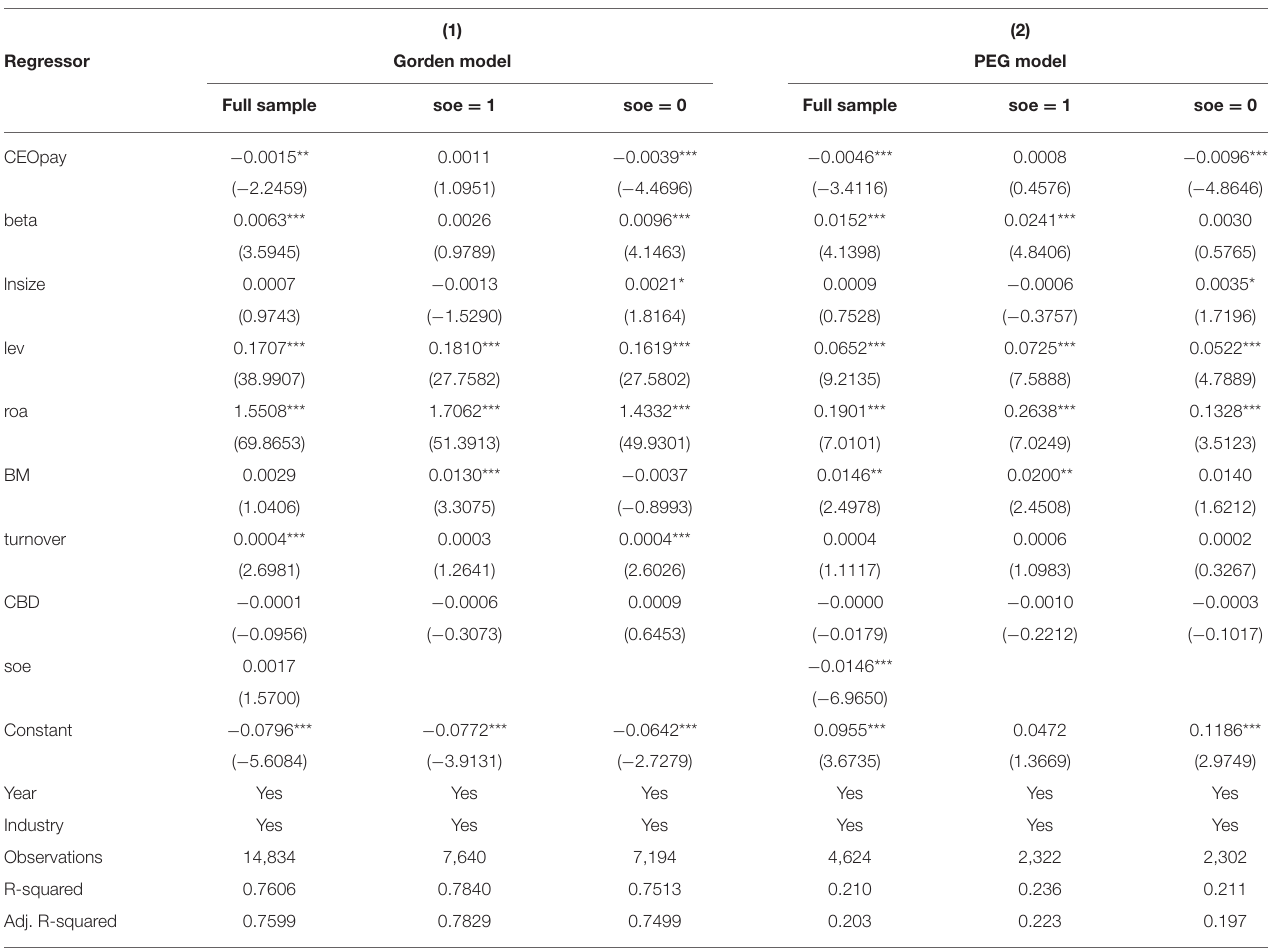
TABLE 9 | Alternative independent variable: CEOpay. (1)